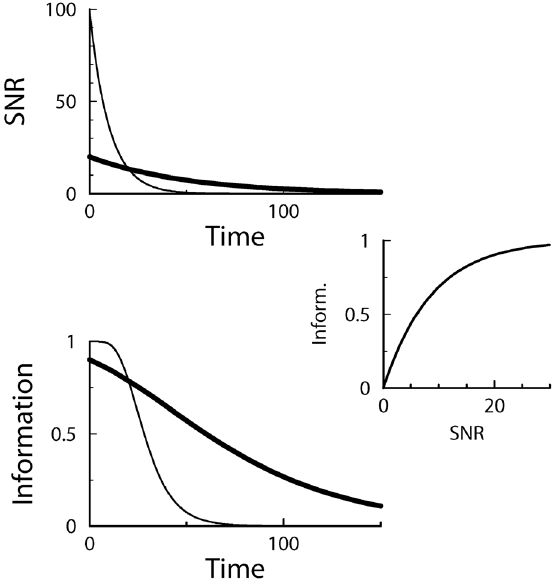
Figure 2. Relation between the information and the SNR. Top: The SNR decay curves versus pattern age for soft-bound plasticity with a large synaptic update (thin curve), and soft-bound plasticity with a small update (thick curve). Although the rules trade off between slow decay and the high initial SNR differently, the area under the curve is identical. Middle: The relation between SNR and Information, Eq.(5). Bottom: The Information versus pattern age calculated from the top and middle graph. The total information stored, equal to the area under the curve, is clearly larger when using small updates (thick curve) than when using large